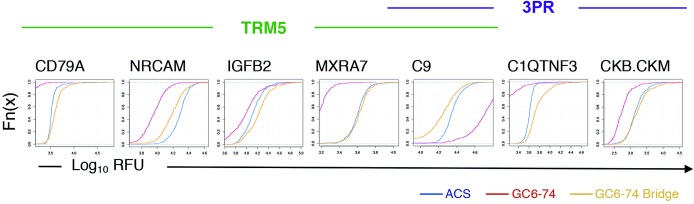
Cumulative distribution of select model proteins run on the custom validation slide arrays.Curves demonstrate a spectrum of distributions of RFU in the ACS versus the GC6–74 cohorts. Red curves represent GC6–74 samples prior to bridging, yellow curves represent GC6–74 postbridging, and blue curves represent ACS samples. ACS, Adolescent Cohort Study; GC6–74, Grand Challenges 6–74; RFU, raw fluoresence unit.